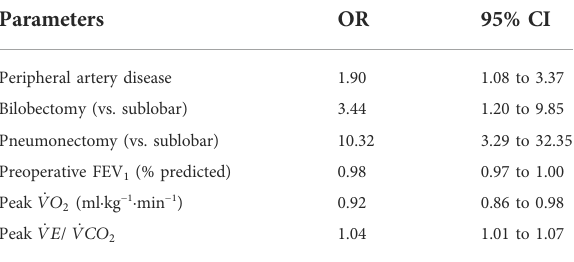
TABLE3Bestpredictorsofpost-operativecomplicationsbasedonthe multivariable regression